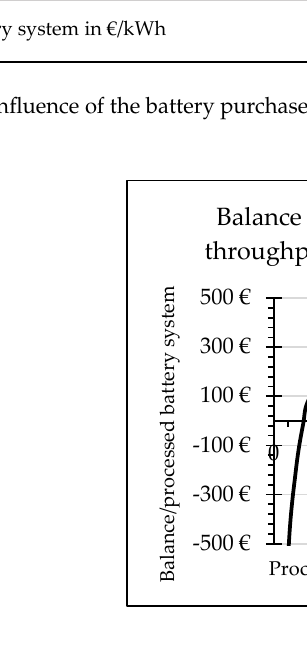
Figure 14. Sensitivity analysis: influence of the battery purchase cost under standard assumptions on the cost – benefit balance.